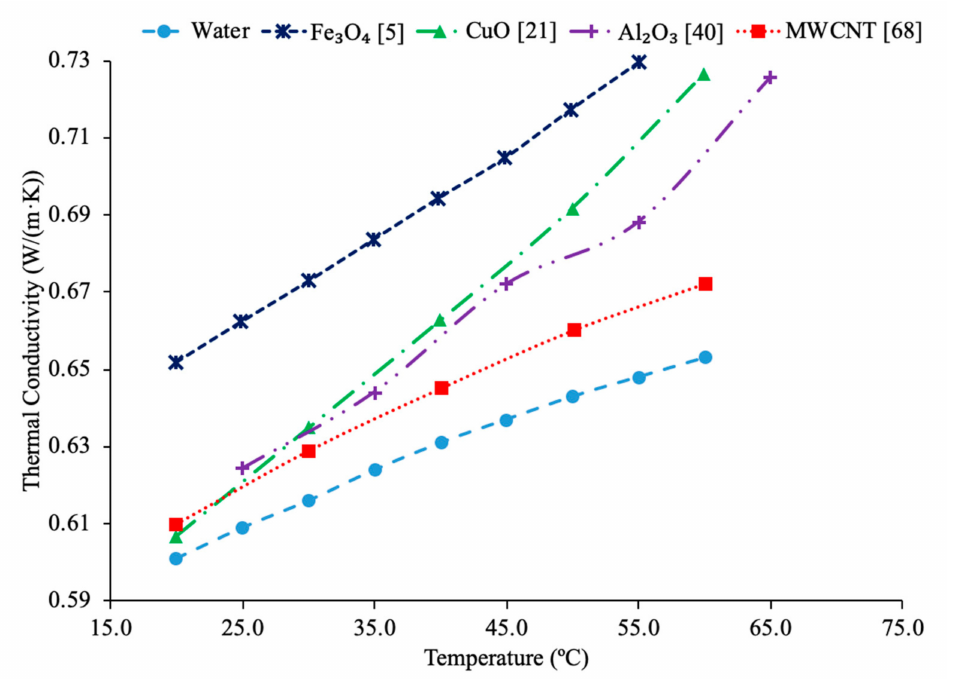
Figure 28. Thermal conductivity of CuO, Al 2 O 3 , Fe 3 O 4 and MWCNT water-based nanofluid as a function of temperature at a volume concentration of 0.05% [5,21,40,68].